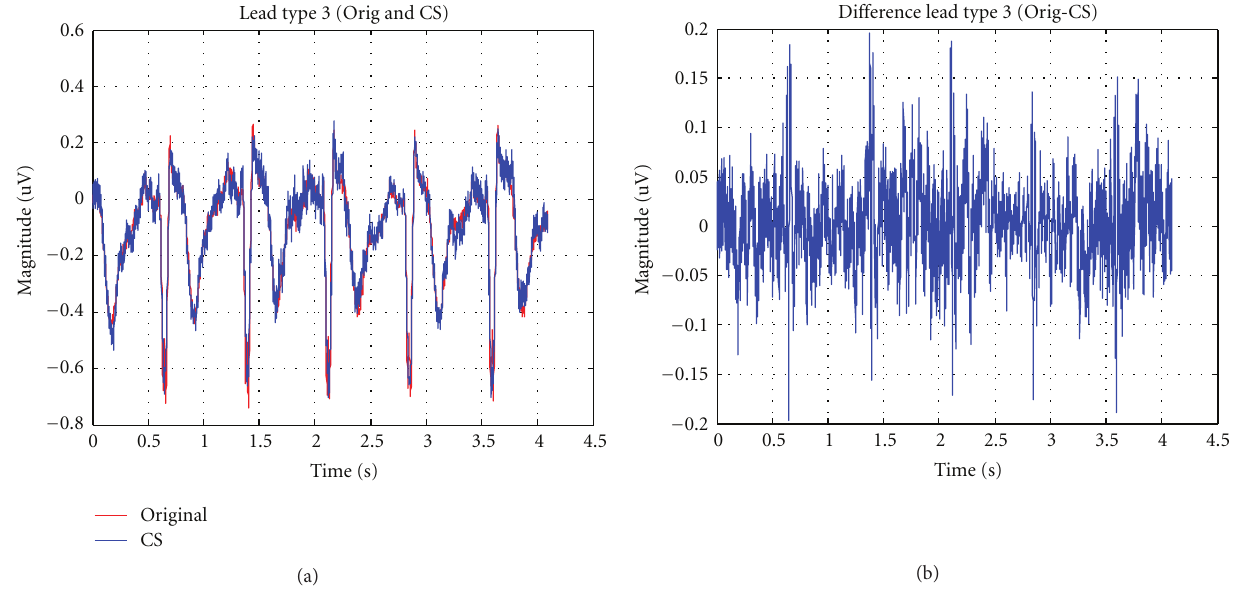
Figure 9: Comparison between the original data and the CS recovering. Figure 9(a) shows Lead type 3 at V3, original in blue and the CS in red, where their difference is depicted in Figure 9(b). The difference is less than 0.08uV.